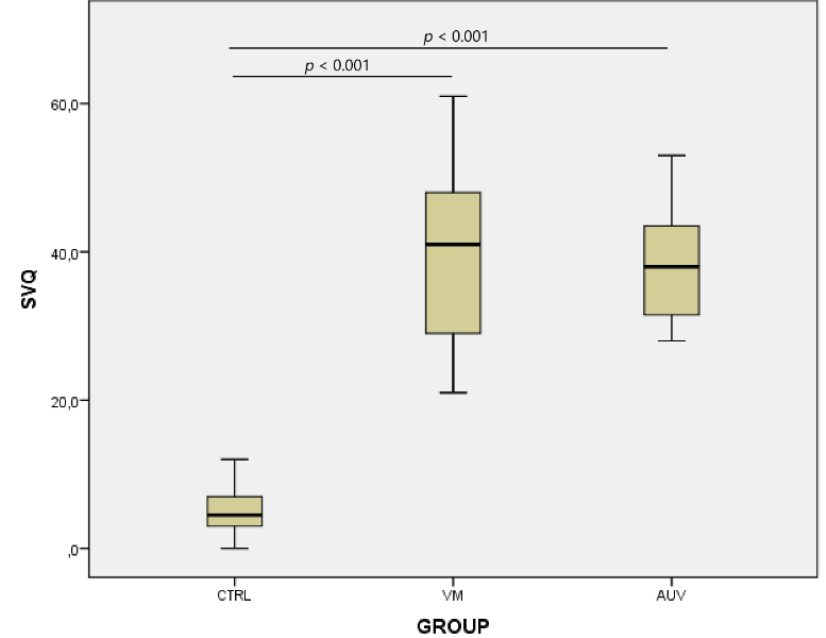
Figure 4. Boxplot showing the SVQ scores in the VM, AUV, and CTRL groups. Significant differences were found between the SVQ scores of VM and the AUV patients and those of the control group ( p < 0.001 and p < 0.001, respectively). No significant differences were found between the VM and AUV groups regarding SVQ scores.